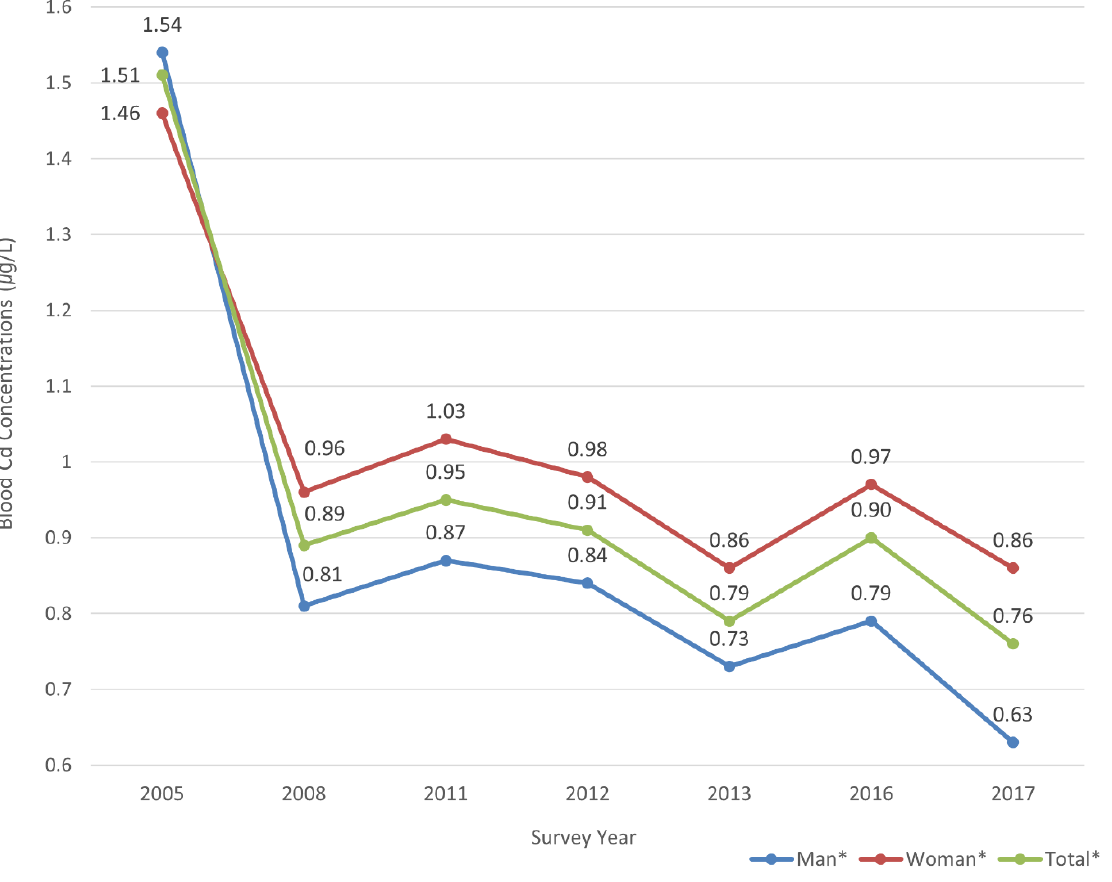
Figure 3. Variation of blood Cd concentrations ( µ g/L) from the 2005 to 2017 surveys. * p < 0.05 using a one-way ANOVA; a Scheffe test was used to compare the 2005 survey with the other survey. All groups (total, men, and women) were significant ( p < 0.05), with the 2005 survey using a Scheffe test employed as the post-hoc analysis.